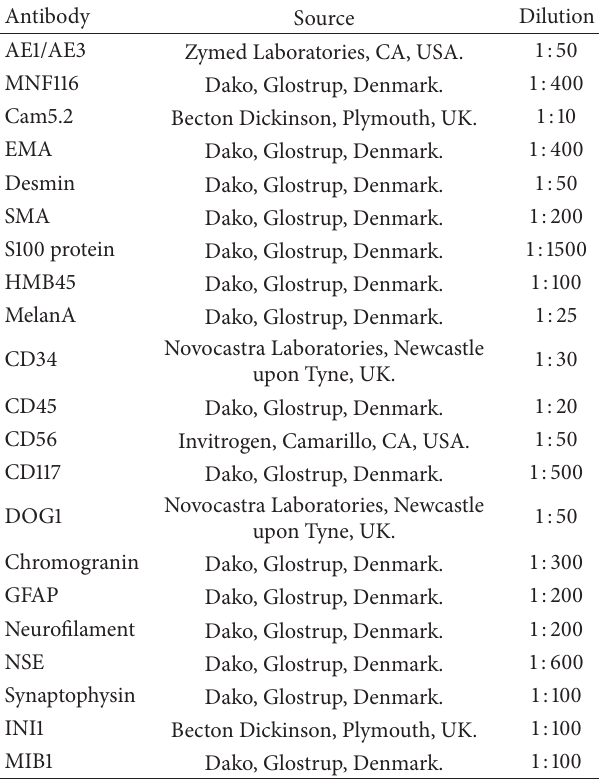
Table 1: Antibodies used for